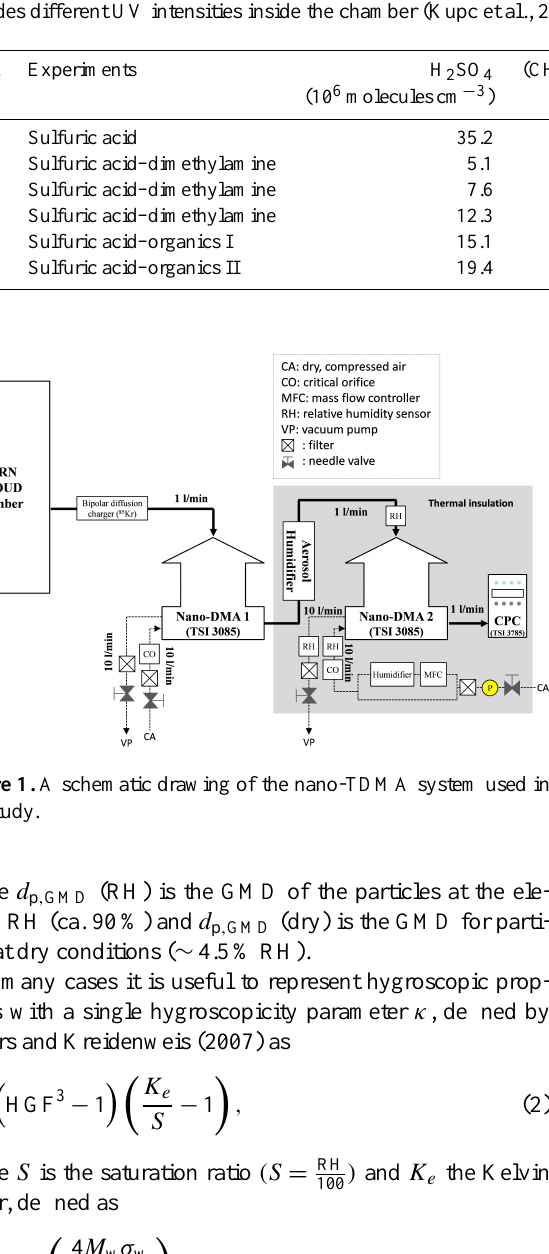
Table 1. Summary of the experimental conditions. The experiments were performed in the presence of sulfuric acid (Exp. A), sulfuric acid and dimethylamine (Exps. B–D), and sulfuric acid and organics produced from α -pinene ozonolysis (Exps. E–F). H 2 SO 4 , (CH 3 ) 2 NH, C 10 H 16 , and O 3 refer to gas concentrations of sulfuric acid, dimethylamine, α -pinene, and ozone, respectively. Here the error in the HGF values indicates the standard deviation for the measured results. UV aperture indicates UV lamp aperture opening (in %), which in turn provides different UV intensities inside the chamber (Kupc et al., 2011).